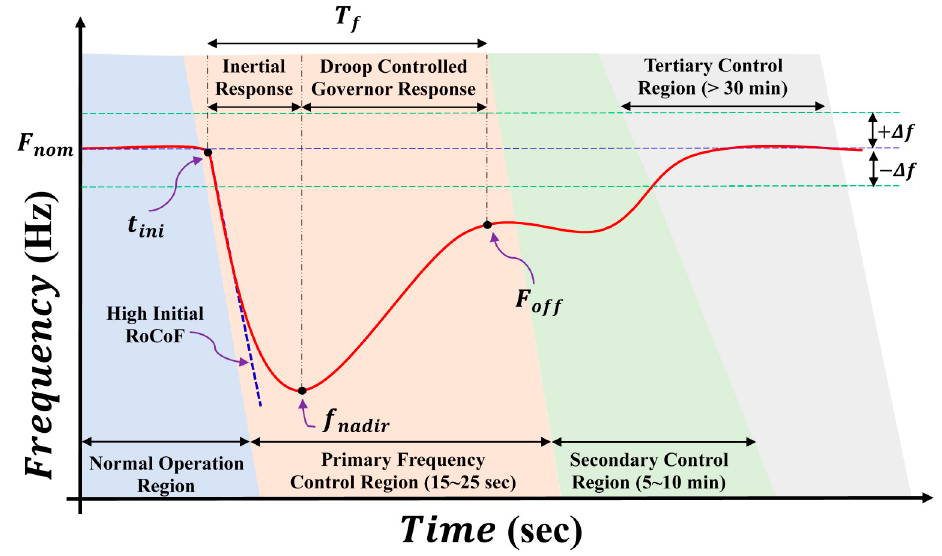
Figure 9. The typical frequency response characteristics of the classical power system consist of the Primary Frequency, Secondary and Tertiary Control regions with their respective durations of events.